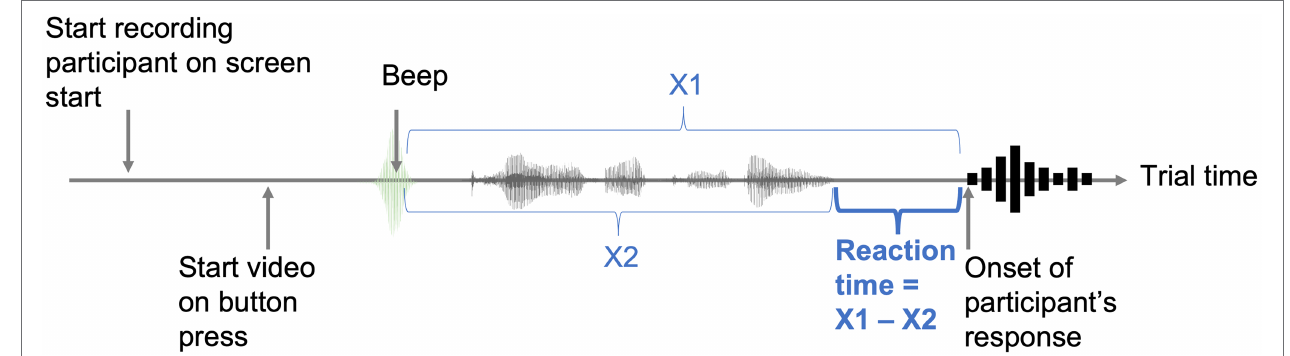
FIGURE 2 | Trial design for capturing reaction times (RT). X1: Duration of trial recording from the beep to the response onset. X2: Duration of stimulus from the beep to the end of the presented